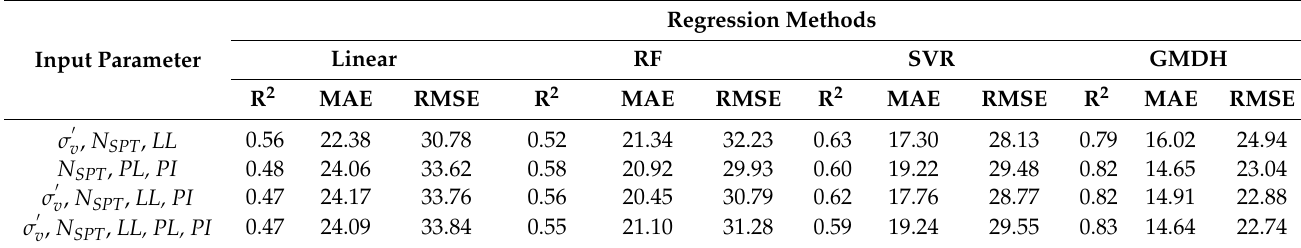
Table 4. Comparative results of the c u prediction models for different input variables.